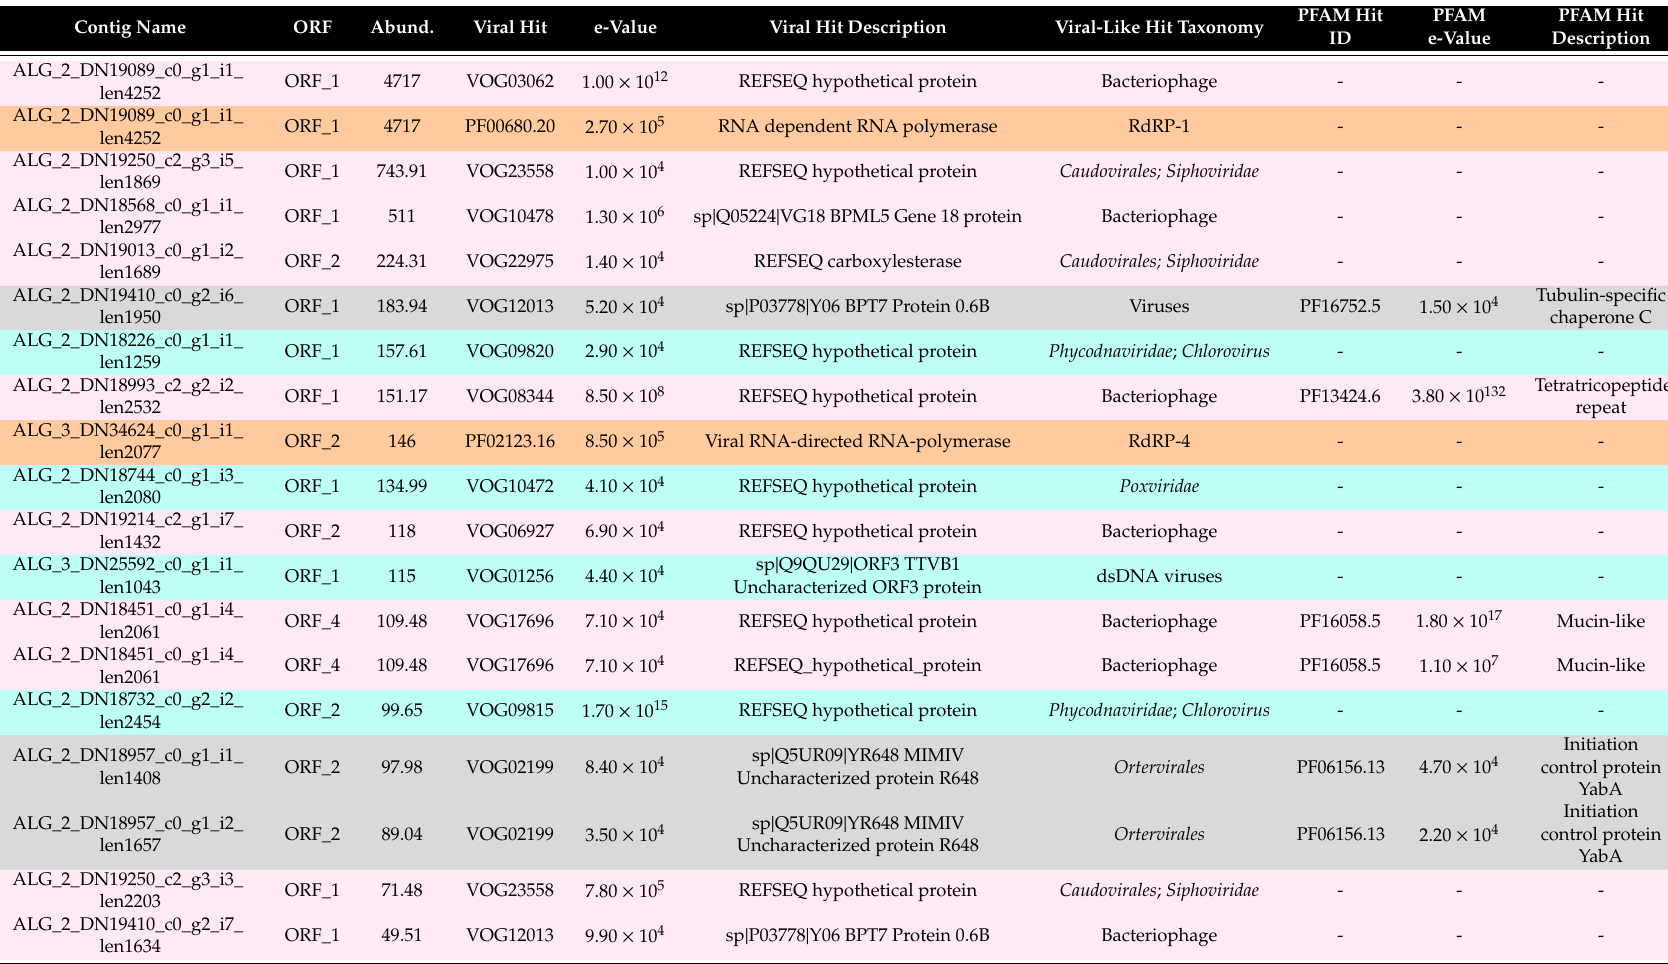
Table 3. Results of the VOGdb and PFAM HMM analysis. Light pink: phage-like sequences. Grey: nonviral sequences; Light blue: DNA virus-like sequences; Orange: RNA virus-like sequences. Abund: expected read counts estimated using the RSEM